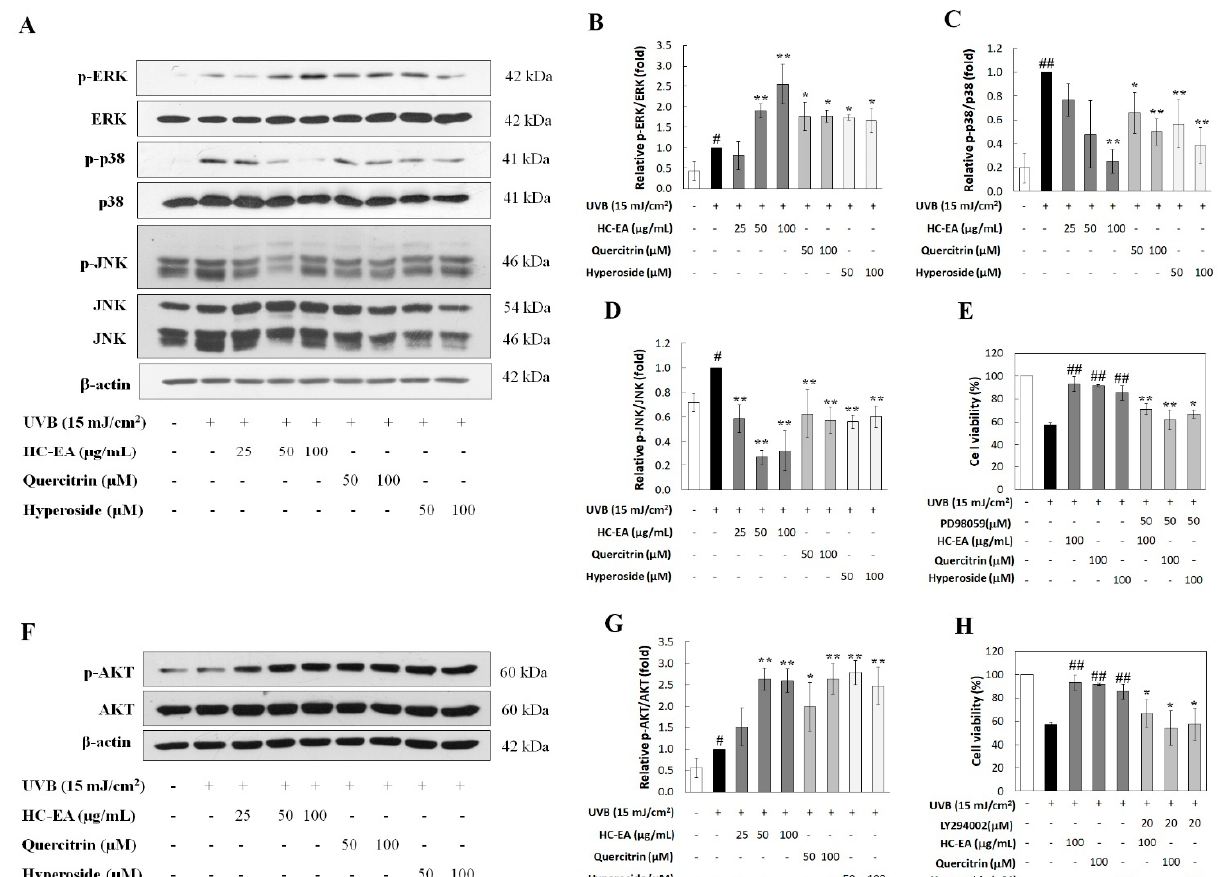
Figure 6. Effect of HC ‐ EA and its active compounds on the modulation of MAPKs and Akt signaling pathway. HaCaT cells were pretreated with the indicated concentrations of HC ‐ EA and its active compounds for 6 h. After UVB irradiation for 1 h, the cells were collected and subjected to investi ‐ gation of the activation of MAPKs ( A ) and Akt ( F ) by Western blot analysis. Densitometric and sta ‐ tistical analysis were performed to determine the relative phosphorylation ratio of ERK ( B ), p ‐ 38 ( C ), JNK ( D ) and Akt ( G ). All experiments were performed at least three times. * p < 0.05, ** p < 0.01, as compared to the UVB ‐ irradiated alone group. # p < 0.05, ## p < 0.01, as compared to the control group. Data are representative of three independent experiments as mean ± SD. To investigate the activation effect of ERK and Akt by HC ‐ EA and its active compounds, which is responsible for pho ‐ toprotection in UVB ‐ induced cell damage, the cells were pretreated with HC ‐ EA or its active com ‐ pounds along with ERK inhibitor (PD98056) ( E ) or Akt inhibitor (LY294002) ( H ). After UVB irradi ‐ ation for 24 h, cell viability was determined by SRB assay. All experiments were performed at least three times. * p < 0.05, ** p < 0.01, as compared to UVB ‐ irradiated combination with the tested com ‐ pounds group. ## p < 0.01 as compared to the UVB ‐ irradiated alone group. Data are representative of three independent experiments as mean ± SD.